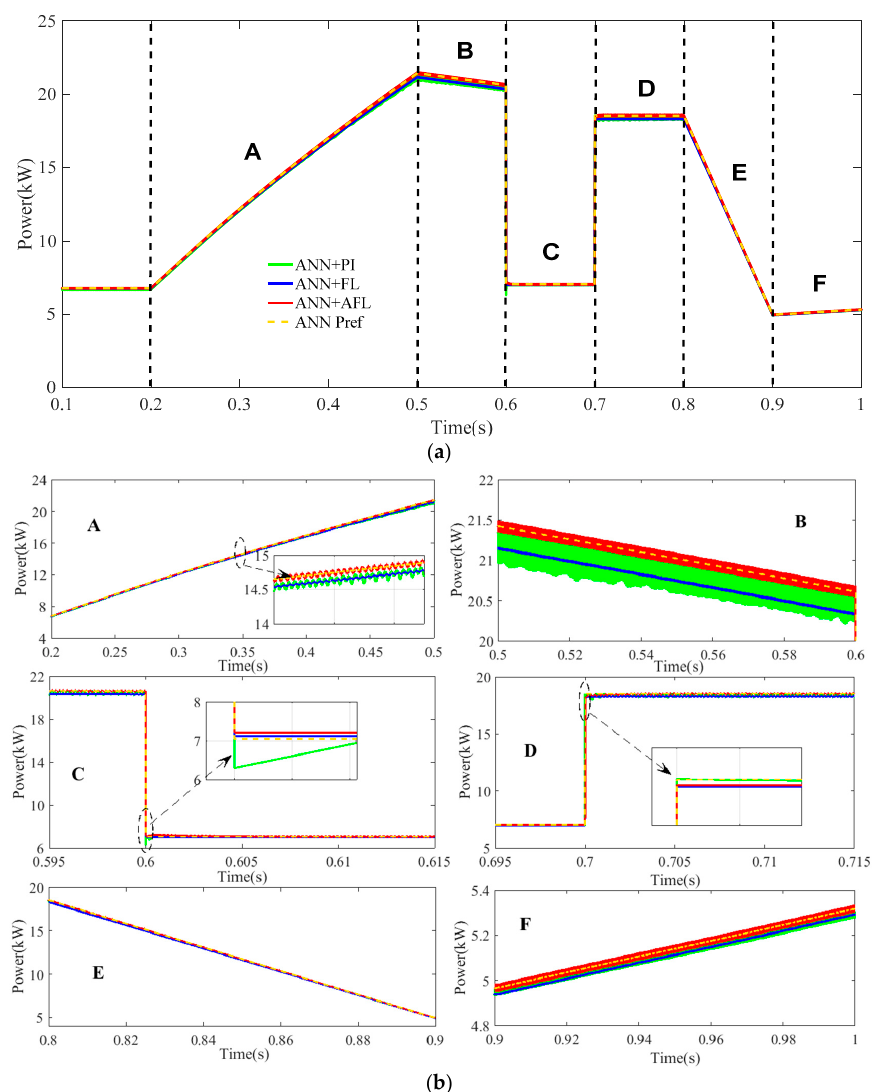
Figure 11. Output powers of PV systems with ANN and different DC/DC control strategies: ( a ) Output power (overall); ( b ) Output power (detailed). Energies 2016 , 9 , 1005